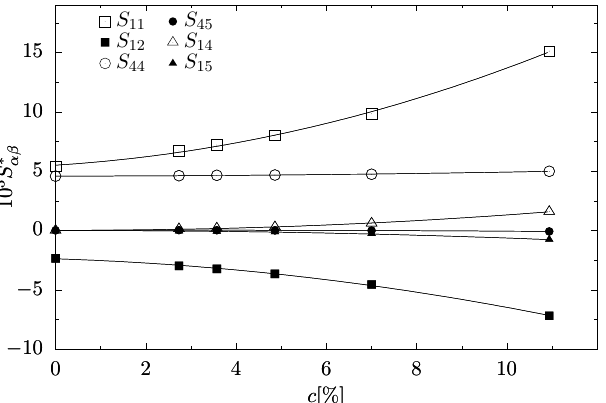
Figure 3. Elements of the elastic compliance matrix S with respect to the concentration, studied at: p ∗ = 100, κσ = 10 and β(cid:101) =